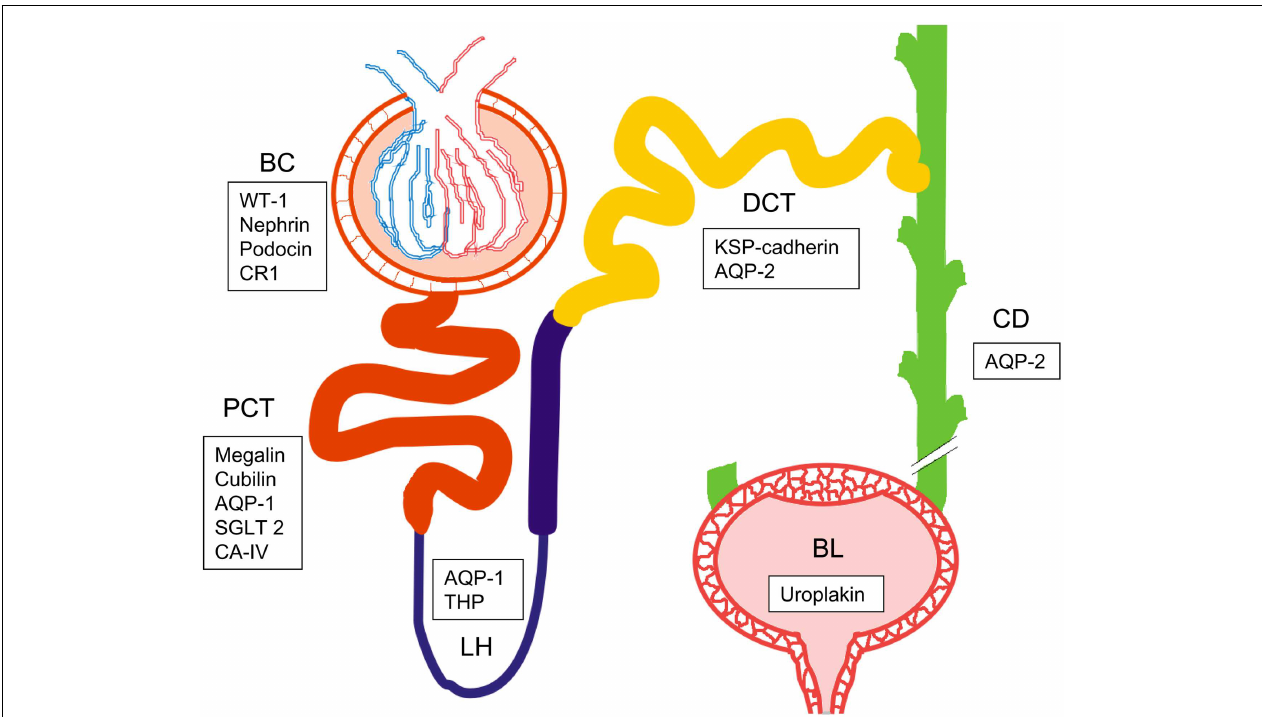
presented in frames.WT-1,Wilm’s tumor 1; CR1, complement receptor 1; AQP1, aquaporin 1; SGLT2, sodium-glucose linked transporter 2; CA-IV, carbonic anhydrase IV;THP,Tamm-Horsfall protein; KSP-cadherin, kidney specific cadherin; AQP2, aquaporin